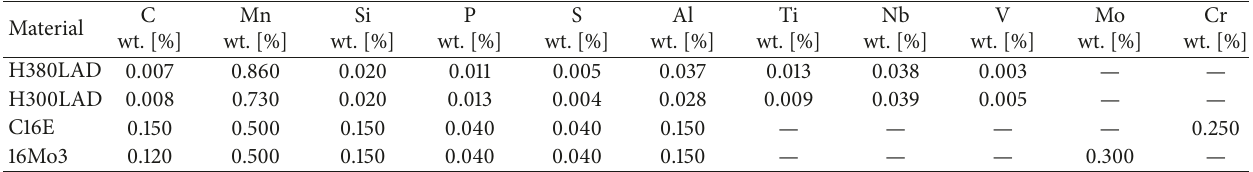
Figure 1: Microstructure microalloyed steels (a) H300LAD and (b) H380LAD. Table 1: Chemical composition of tested microalloyed and standardly-used